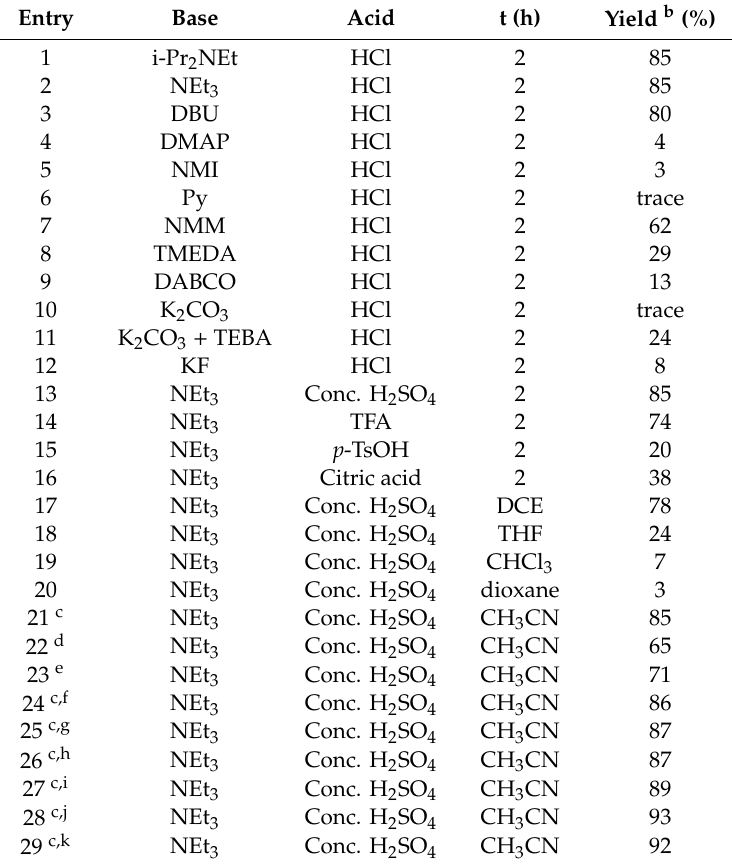
Table 1. The screening of catalysts and acidifiers a